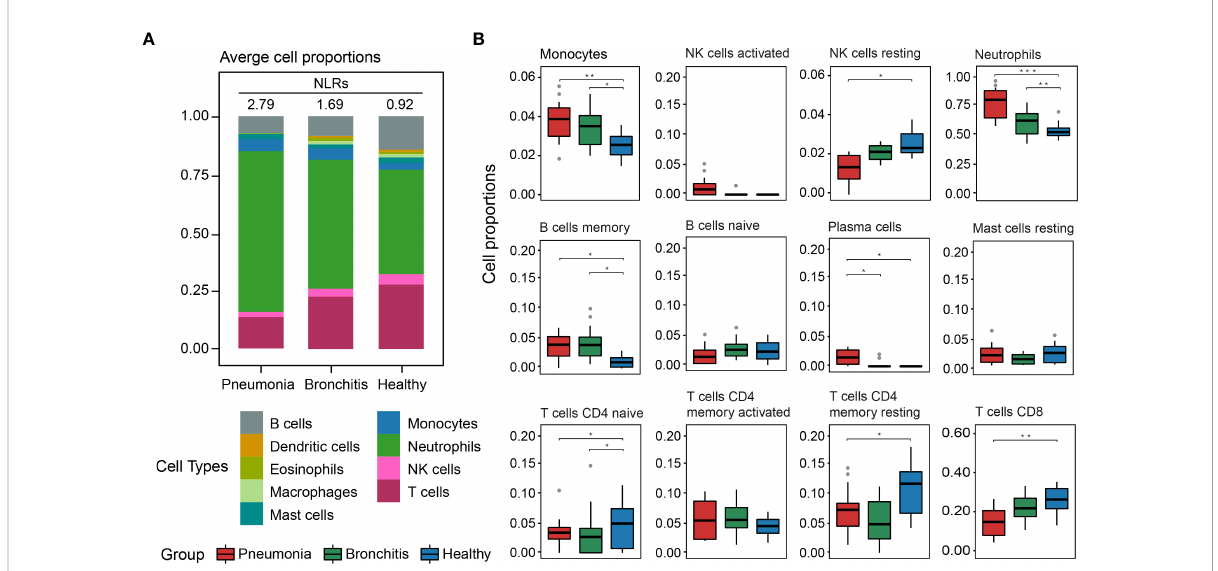
FIGURE 5 Composition of immune cells in PBMCs in C. psittaci cases compared to healthy controls determined from transcriptome data. (A) The proportion of nine major immune cell types. The neutrophil-to-lymphocyte ratios (NLRs) are shown in (A) . (B) The proportion of 12 immunity- related cell subtypes. Asterisks represent signi fi cant differences between groups (* p -value < 0.05, ** p -value < 0.01, *** p -value < 0.001, Mann – Whitney